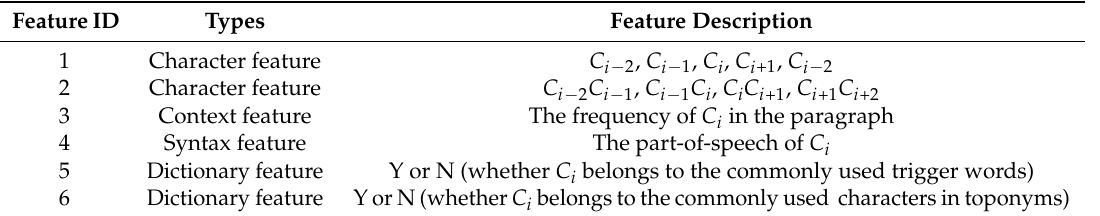
Table 5. Main features of the CRF model.